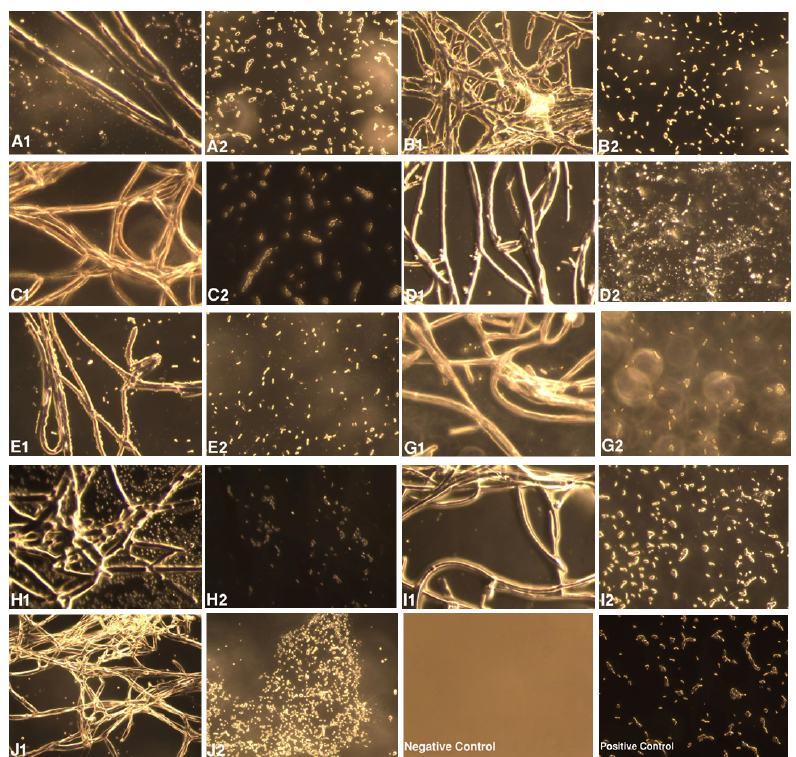
Figure 1. Digital images (400X) of microscopic analysis in dark phase representing the interactions of different Trichoderma species against Ralstonia spp. A1–J1 shows strains AA2, AG3, AKD, A5, A9, A10, ATA, ATH and ATV, respectively (see Table 1), growing on Ralstonia spp., which was cotton swabbed onto CPG agar plates. A2–J2 represents growth of Ralstonia spp . 4 cm away from the growth of Trichoderma spp., viz., A2, AG3, AKD, A5, A9, A10, ATA, ATH and ATV, respectively, on the plate. Negative control (i.e., blank plate without any swabbing) and positive controls (i.e. Ralstonia spp. without Trichoderma species) are also included.